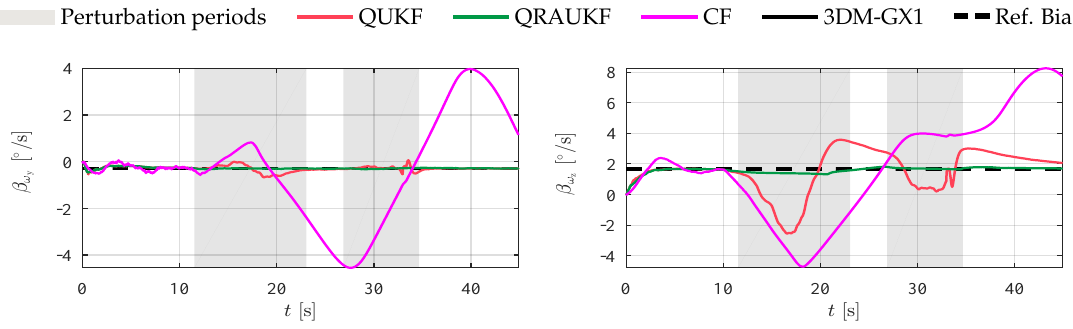
Figure 5. Bias estimate of angular rate ω y and ω z , respectively, measured by the gyros for second experiment, scenario (ii).